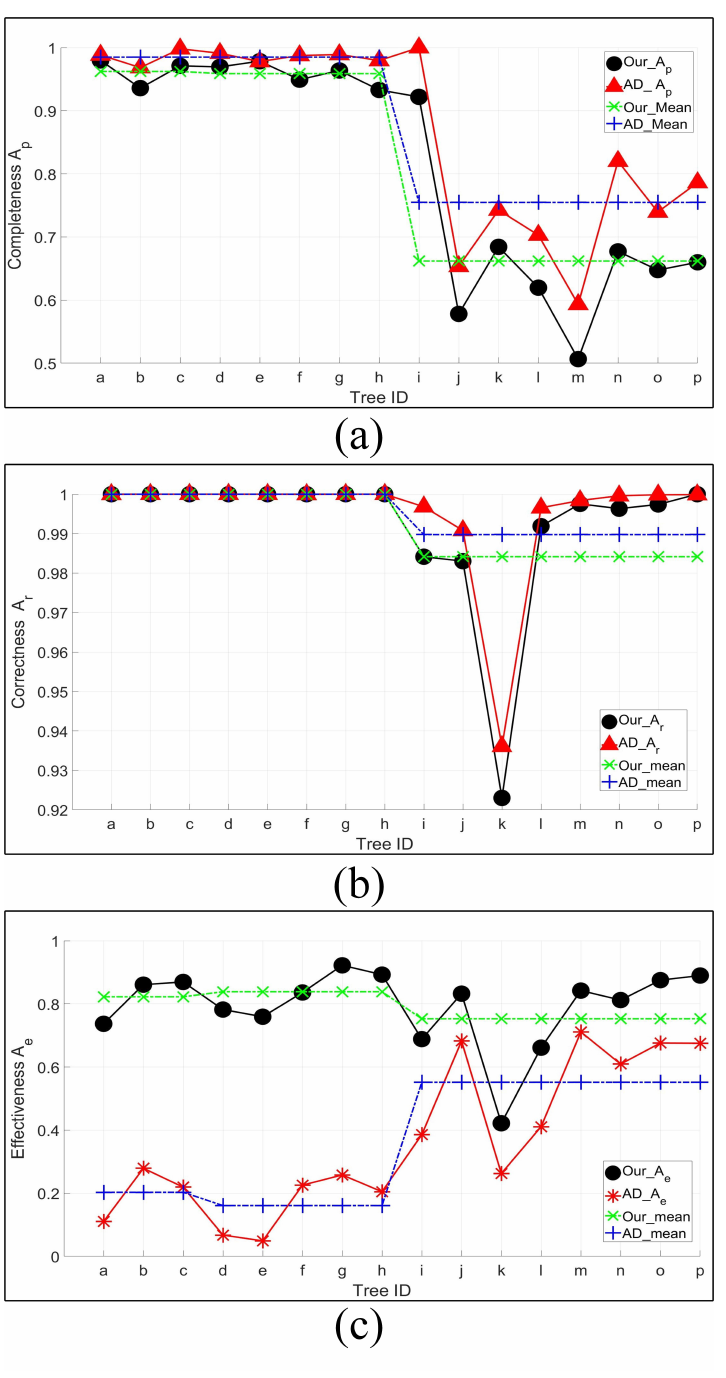
Figure 9. Quantitative comparison of our method and AD. ( a ) Completeness. ( b ) Correctness. ( c )